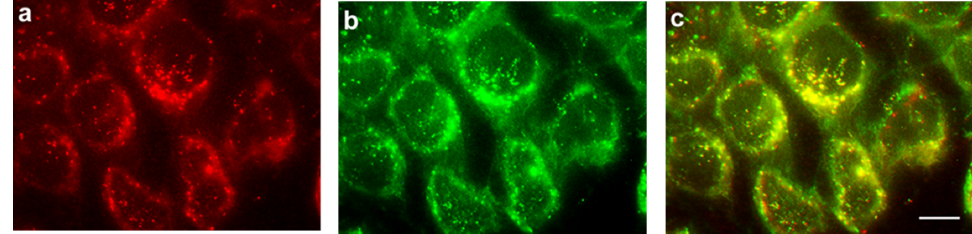
Figure 9. HeLa cells treated with 2 µ M PhA and 50 nM LysoTracker Green for 4 h, observed by fluorescence microscopy. ( a ) PhA fluorescence observed under green light excitation; ( b ) LysoTracker Green fluorescence under blue light excitation; ( c ) merged images from ( a ) and ( b ). Scale bar: 10 µ